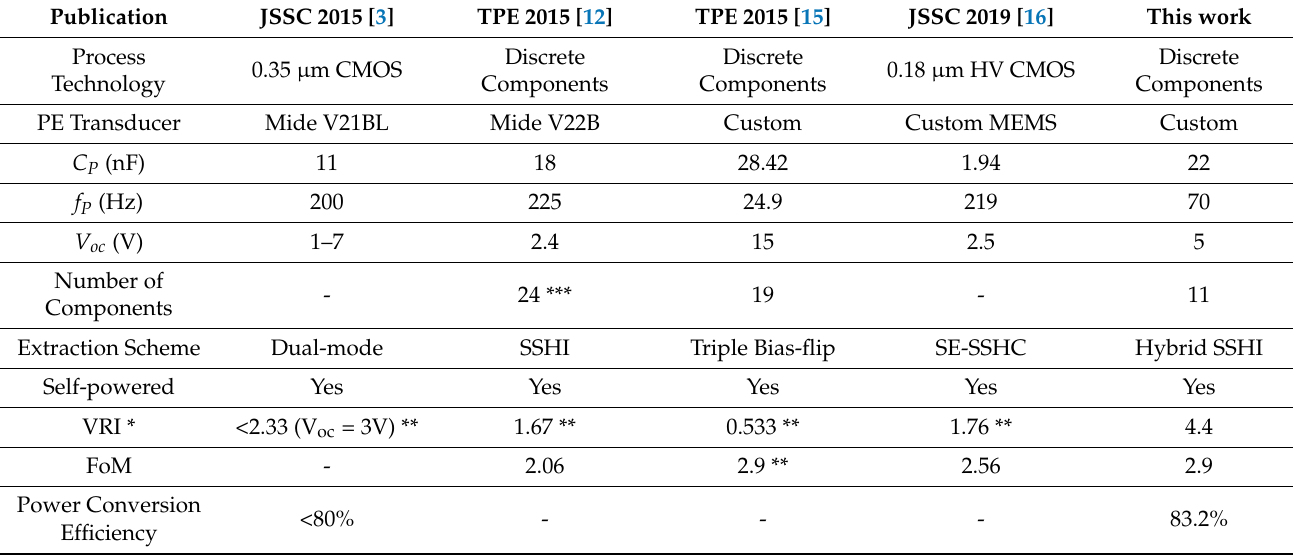
Table 3. Comparison of recent PE energy harvesting